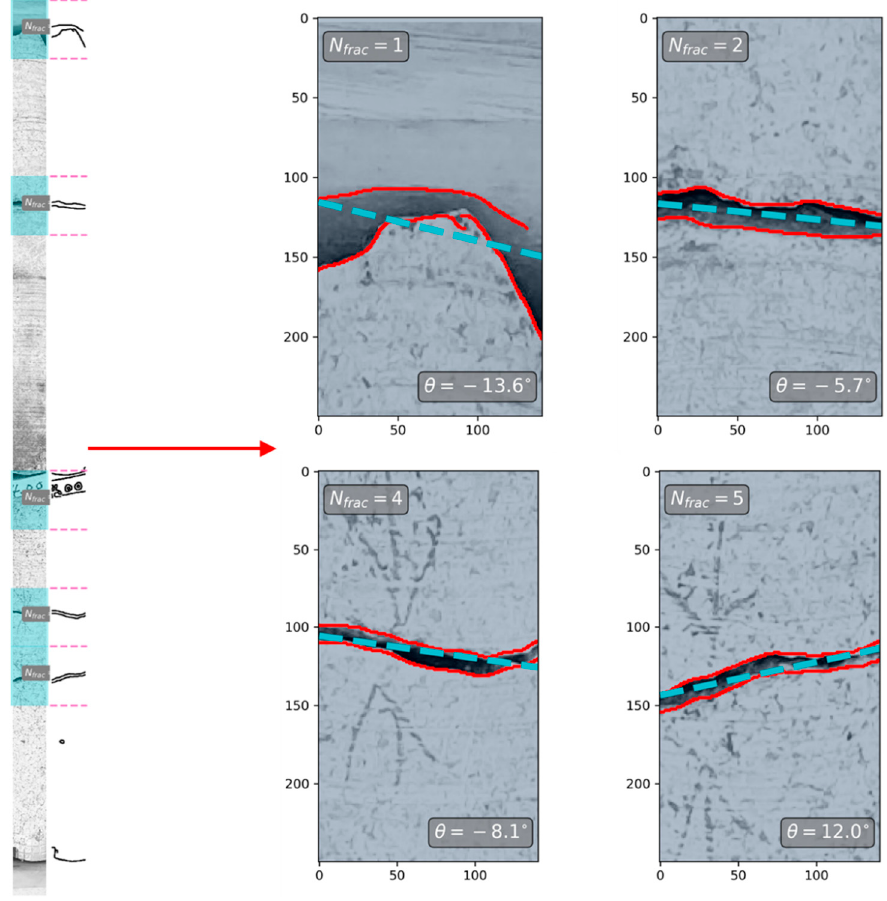
Figure 5. Example of measuring the angles of the fractures through linear fitting.